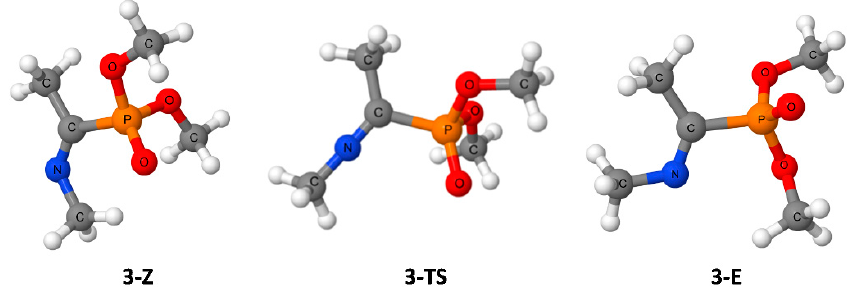
7 Figure 6. Optimized structures of Z- and E-isomers ( 2-Z and 2-E , respectively) and the transition state of the isomerization reaction 2-Z → 2- Е ( 2-TS ). In contrast to compounds 1 and 2 , for methyl derivative 3 (Figure 7), the 3-E isomer